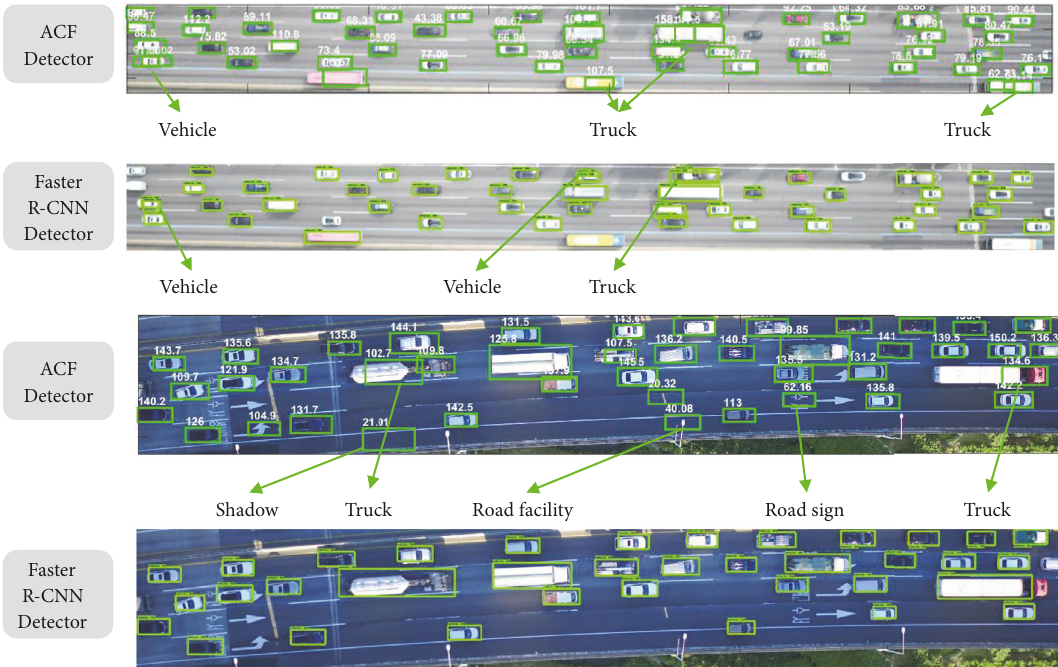
Figure 6: False positives from the two different detectors for each